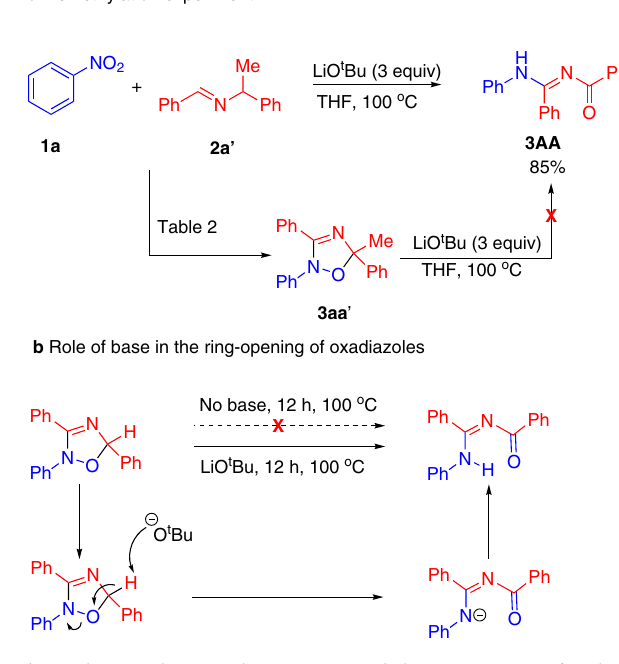
Fig. 6 Ring-opening experiments. a Demethylation experiment. b Role of base in ring-opening of